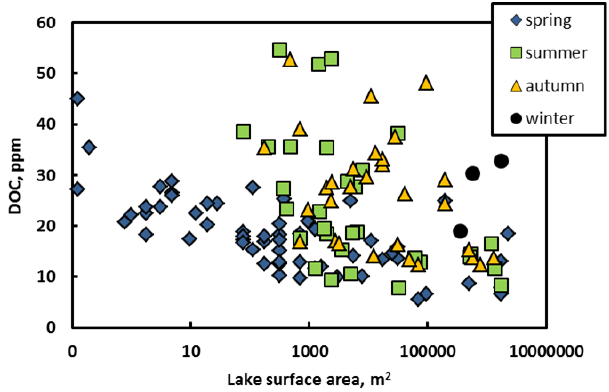
Figure 3. UV absorbance properties of thermokarst lake waters. The UV 280 /DOC ratio increases in the order spring < summer < autumn, suggesting the progressive increase in aromaticity that is independent of the lake size ( p > 0.05). The average values of UV 280nm /[DOC] are equal to 0.024 ± 0.0037, 0.030 ± 0.0072, 0.035 ± 0.0069, and 0.0354 ± 0.0068Lmg − 1 cm − 1 in spring, sum- mer, autumn and winter, respectively.